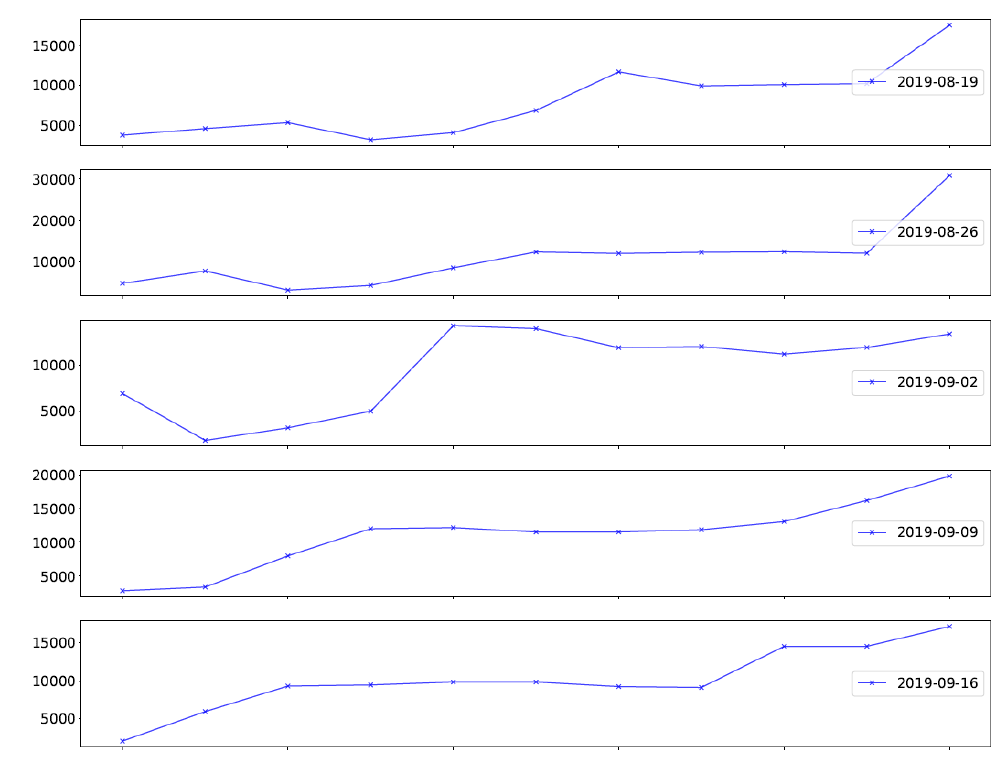
Figure 4. Time series of demands of a high-risk